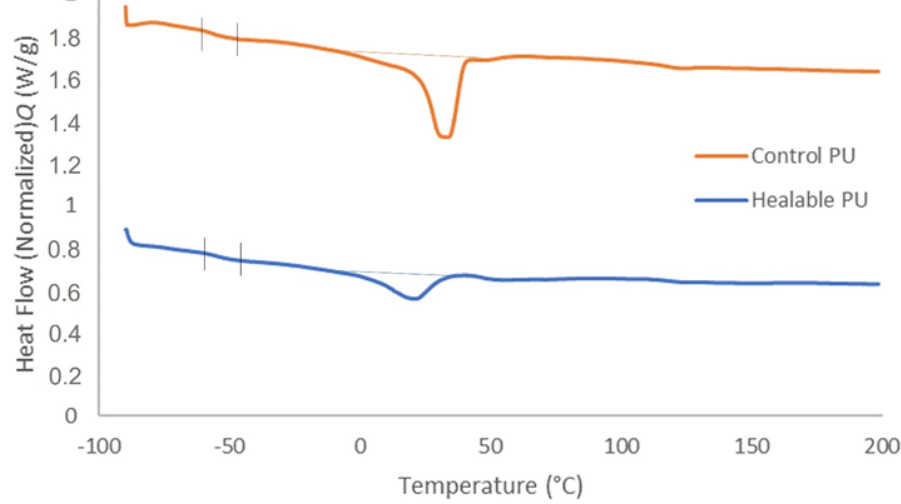
Figure 7. DSC curve of the bio-based 2K PU coatings.